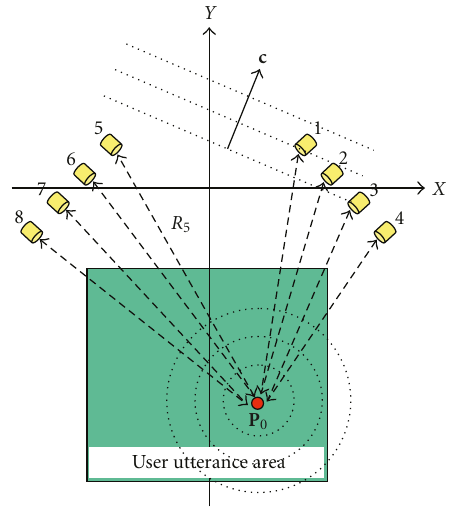
Figure 2: Schematic diagram of wave